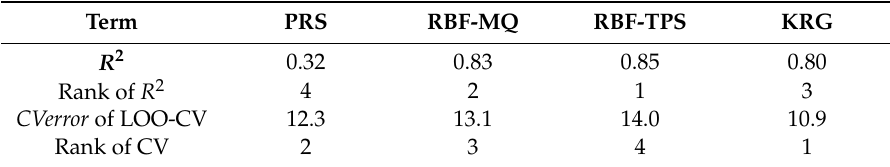
Figure 1. Comparison of different surrogate models. Table 1. Rank of models by R 2 and leave-one-out CV (LOO-CV)